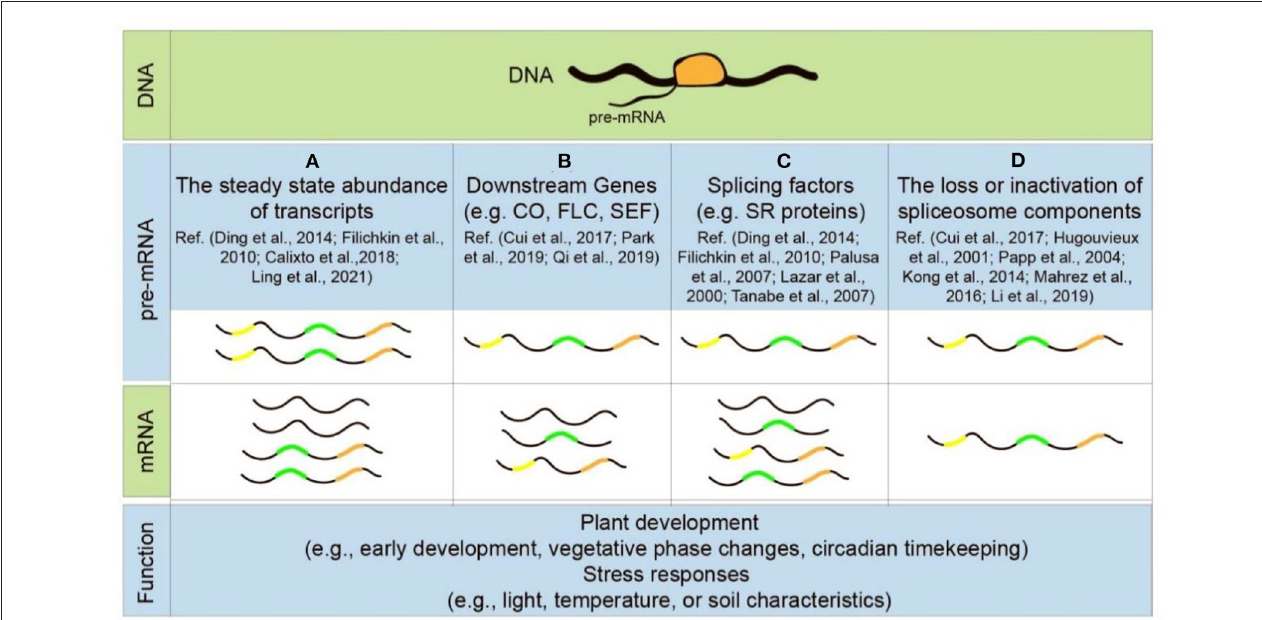
FIGURE 4 | Patterns of alternative splicing during plant development and stress response. Each step of pre-mRNA splicing influences plant growth and adaptation to environments, such as the steady-state abundance of transcripts (A) , the alternative splicing of downstream genes (B) , splicing factors (C) , and the loss or inactivation of spliceosomal components (D)